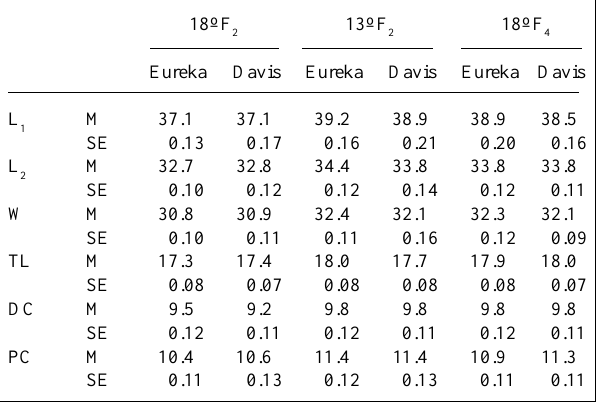
Table II - Mean value (M) and standard error (SE) of the continuous variables L1, L2, W and TL and the meristic variables DC and PC, for the Drosophila subobscura males of each characterized group - Eureka 18º